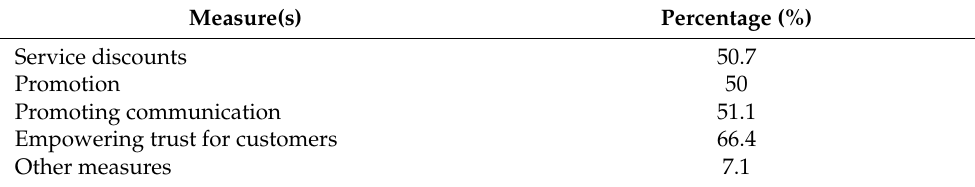
Table 5. Measures to recover business operations of enterprises (n = 280). Measure(s) Percentage (%) Service discounts 50.7 Promotion 50